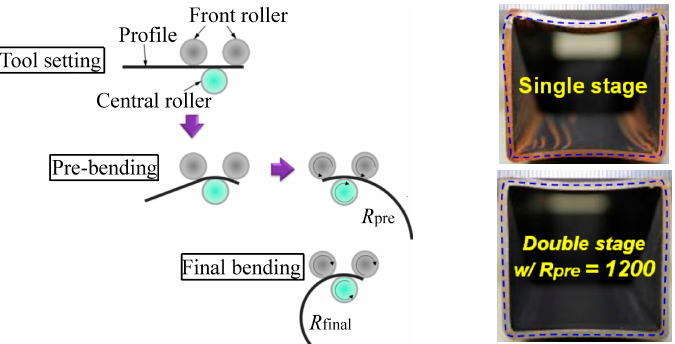
Figure 12. Double-stage forming of profiles with large curvature (pipes: 40 mm × 40 mm × 2 mm). Reproduced with permission from ref. [55]. Copyright 2016 Elsevier B.V.